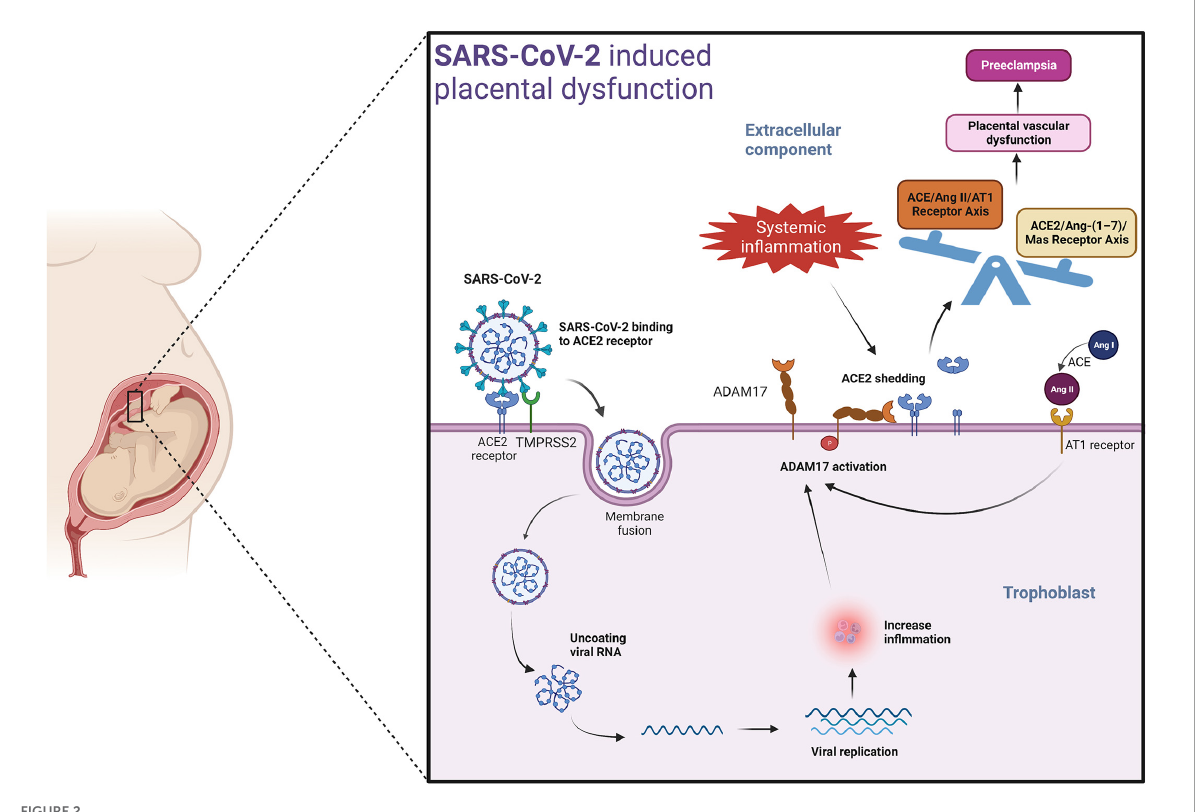
FIGURE2 Mechanism involved in SARS-CoV-2 induced placental